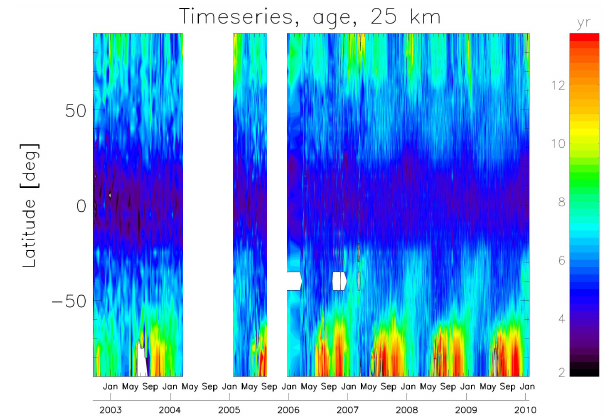
Fig.4. Comparisonof MIPASAoAlatitudecross-sections at 20kmaltitude(coloredcurvesand shaded area) withAoAderivedfromearlierairborneSF 6 (blacktriangles)andCO 2 measurements(greydiamondswitherror altitude (colored curves and shaded area) with AoA derived from bars)aspublishedinWaughandHall(2002)andHalletal.(1999). Theshadedarearepresentstherangeofall earlier airborne SF 6 (black triangles) and CO 2 measurements (grey MIPASmonthlymeanAoAobservations,whilethecoloredcurvesshowAoAlatitudinaldependenceforevery diamonds with error bars) as published in Waugh and Hall (2002)